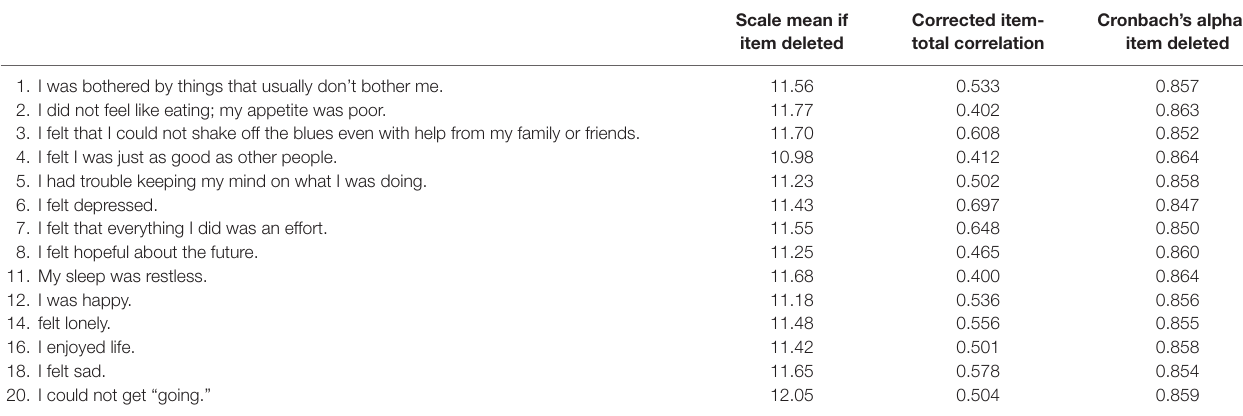
TABLE 4 | Internal consistency of CES-D.